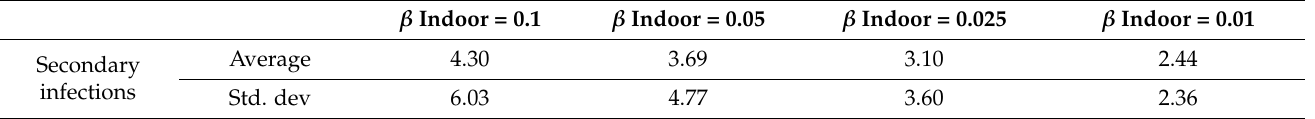
Table 6. Secondary infections between student and dynamic agents obtained from different β indoor values. β Indoor = 0.1